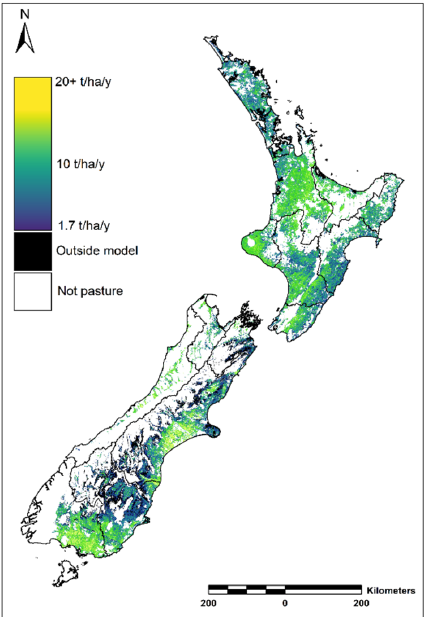
Figure 7. National pasture productivity in New Zealand. White areas are not planted in pasture, and black areas are too low producing to be predicted with this model.